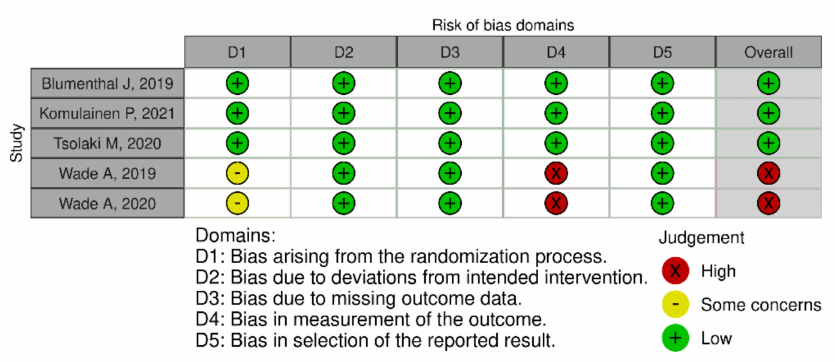
Figure 2. Quality assessment of the RCTs that followed a diet counselling intervention.